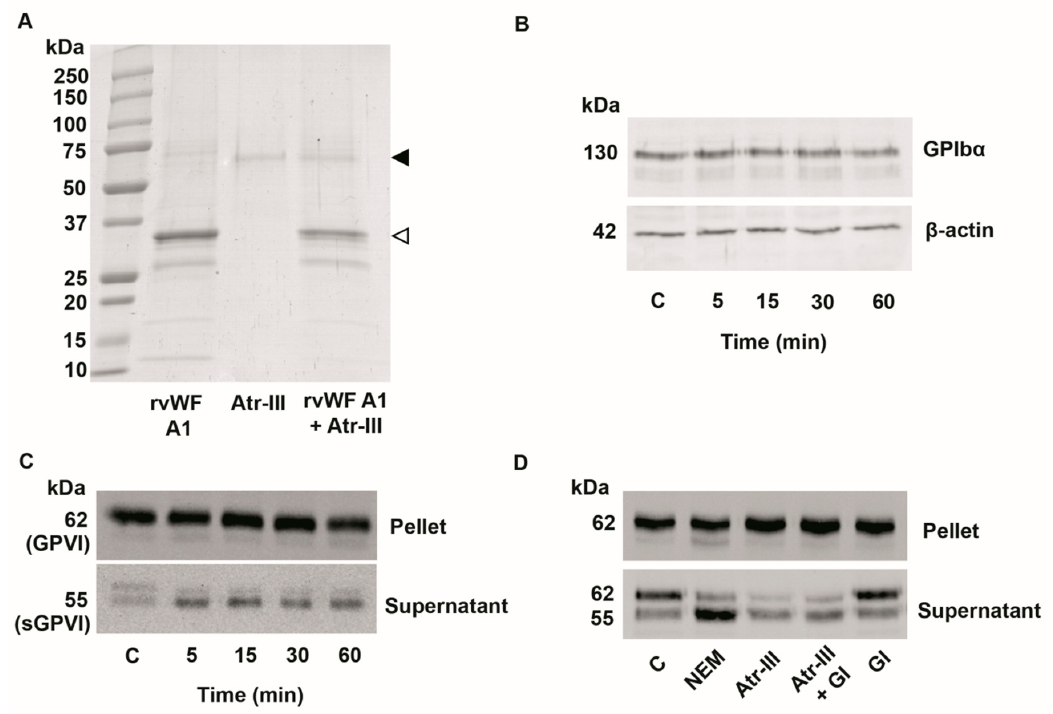
Figure 9. Atr-III does not cleave either the recombinant A1 domain of vWF (rvWF-A1) ( A ) nor GPIb α ( B ). ( A ) 5 µ g Atr-III was incubated with rvWF-A1 (5 µ g) as described in the experimental methods at 37 ◦ C. The proteolysis of rvWF-A1 (indicated by an open arrowhead) was analyzed by SDS-PAGE (5–15%). The black arrow head indicates Atr-III. ( B ) Washed platelets were incubated with Atr-III (10 µ g) at 37 ◦ C at several intervals and the reaction was stopped by addition of SDS loading sample bu ff er. The platelet lysate was blotted with anti-CD42 / GPIb or β -actin as endogenous control. ( C ) Platelet pellets or supernatants of washed platelets treated with Atr-III (10 µ g) at 37 ◦ C at several intervals or ( D ) NEM (10 mM), Atr-III (10 µ g), Atr-III (10 µ g) plus GI254023X (100 nM) and GI254023X (100 nM) alone were blotted with anti-GPVI antibodies. The position of GPVI (62 kDa) and the soluble ~55 kDa GPVI fragment are shown. C = platelet